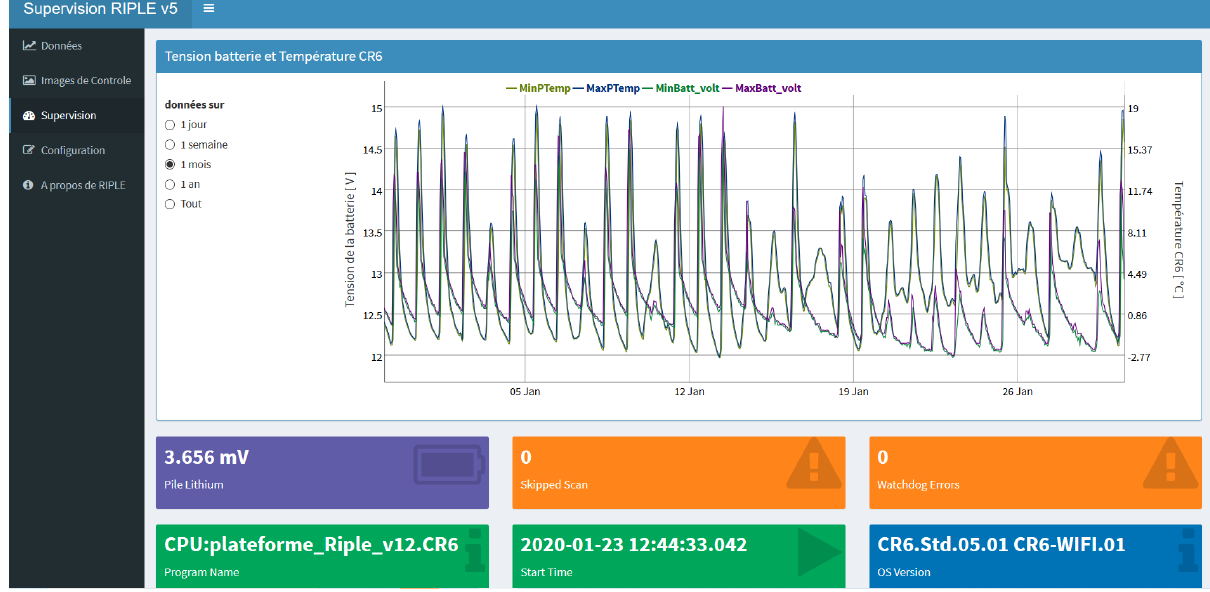
Figure 11. Screenshots of the “Supervision” menu of the user interface. A time series graph is displayed with minimum and maximum battery voltage on the first y axis and min and max air temperature on the second y